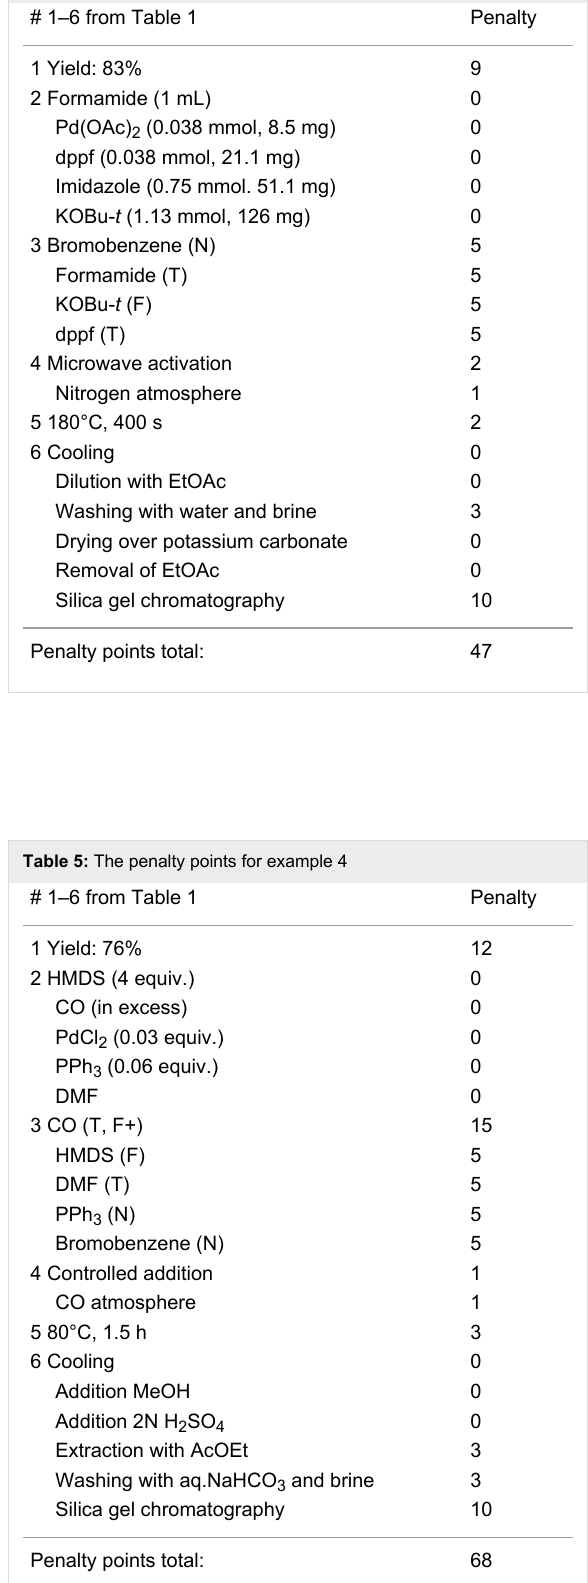
Table 2: The penalty points for example 1 # 1–6 from Table 1